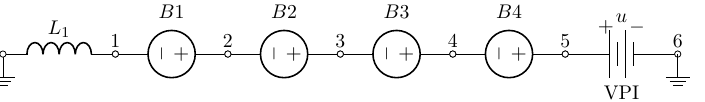
Figure 14. Circuit equivalent to Van der Pol forced equation Figure 15. Circuit equivalent to van der Pol forced equation with a = 118